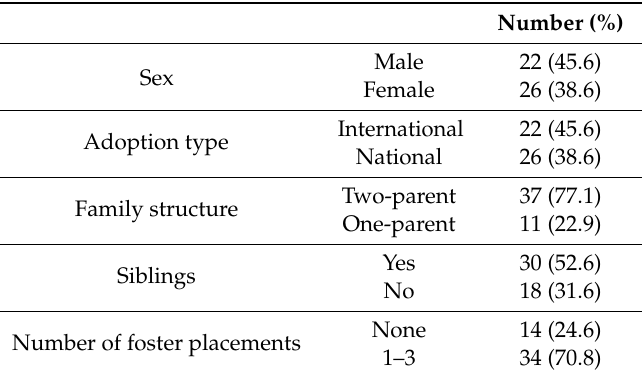
Table 1. Demographic